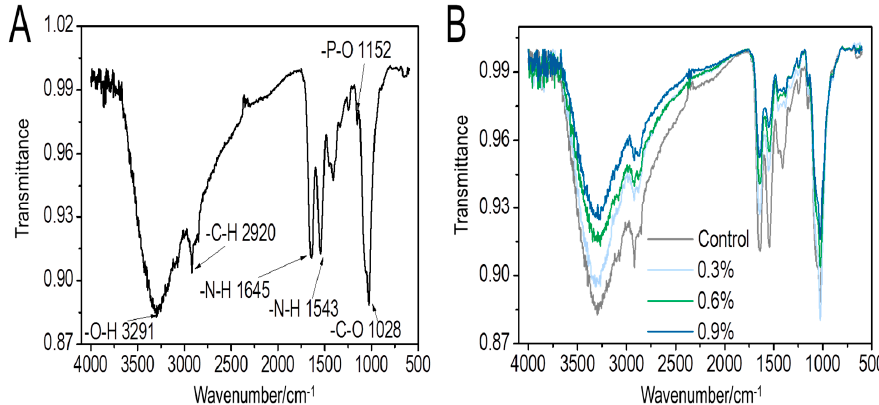
Figure 3. IR spectra of CS/Gel/nHAp/MWCNTs scaffolds. ( A ): Chemical functional group analysis of the CS/Gel/nHAp scaffold; ( B ): IR spectra comparison of each CS/Gel/nHAp/MWCNTs scaffold. The characteristic peaks of the scaffolds did not change; only the transmittance changed with MWCNT content.